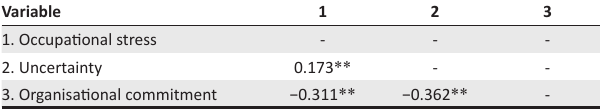
TABLE 5: Pearson product–moment correlation